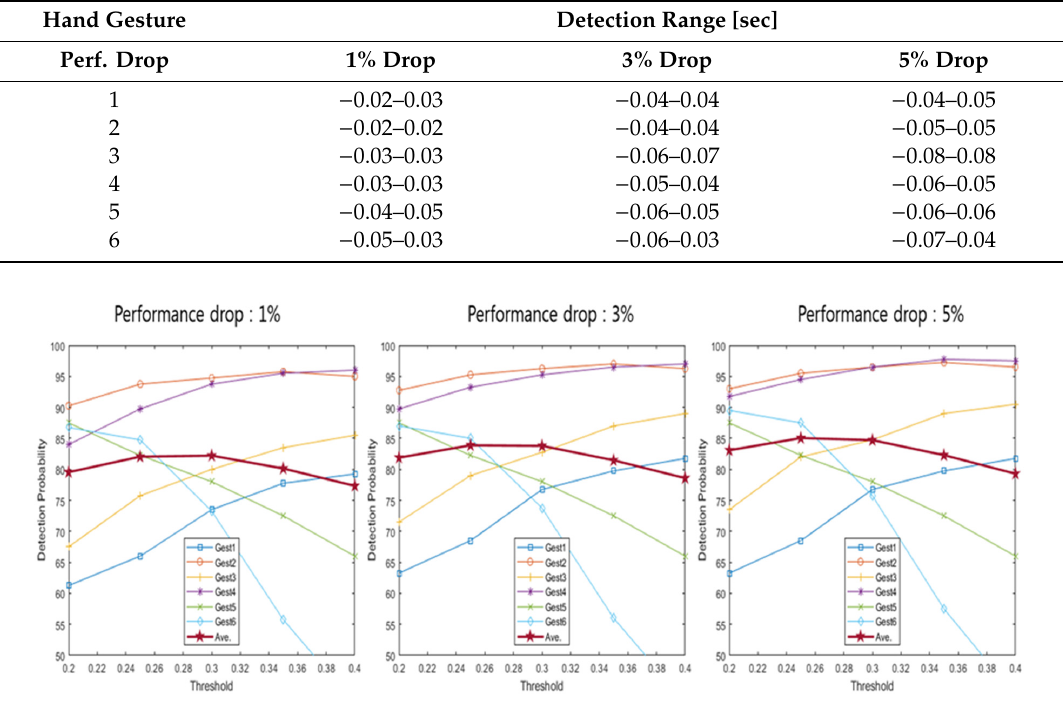
Figure 9. Detection probability of conventional method [20].